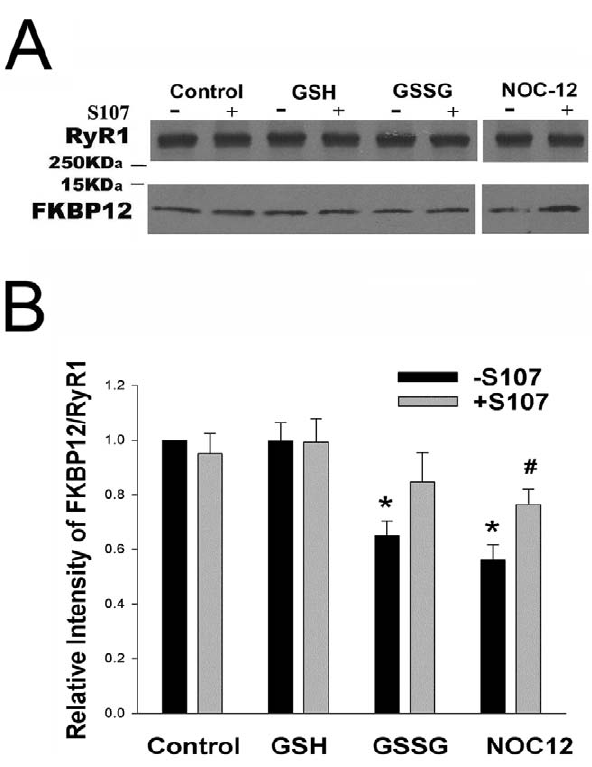
Figure 5. Effect of S107 on the stability of FKBP12-RyR1 complex in skeletal muscle homogenates. (A and B) Skeletal muscle homogenates were incubated without (control) or with 5 mM GSH, 5 mM GSSG or 0.10 mM NOC12 in the absence or presence of 44 m M S107 for 20 h at 24 u C. Unbound FKBP12 was removed by centrifugation and the amounts of RyR1 and FKBP12 were detected using anti-RyR1 and anti-FKBP12 antibodies. Homogenates incubated without glutathione and NOC12 served as control. Data are the mean 6 SEM of 8 experiments. *p , 0.05 compared to control homogenates without S107. # p , 0.05 compared to homogenates incubated with NOC12 in the absence of S107. doi:10.1371/journal.pone.0054208.g005 (1:10 dilution) for 20 h at 4 u C. Protein G coupled to magnetic beads was added and samples were incubated for 2 h at 4 u C. After washing twice with 20 mM NaPipes, pH 7.2 containing 0.125 M NaCl, 0.3% Triton X-100 and protease inhibitors, bound proteins were released with 30 m l 4 6 SDS buffer at 37 u C for 20 min and separated on SDS gels and analyzed on immunoblots as described above.